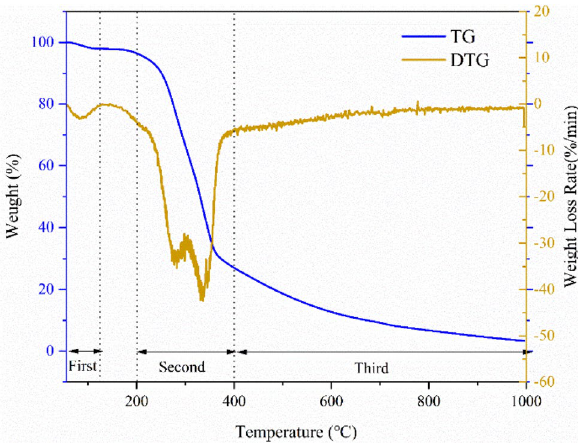
Figure 2. TG/DTG curves of corn